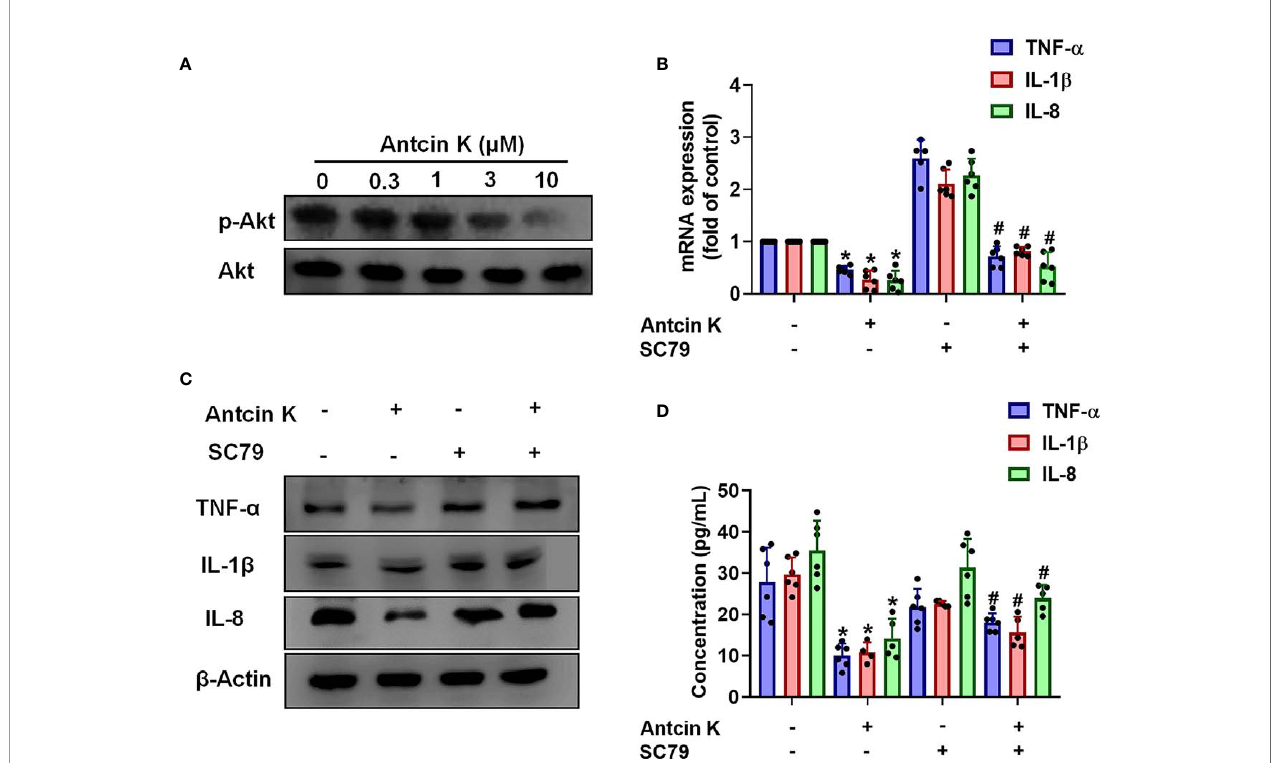
FIGURE 5 | The AKT pathway is involved in Antcin K-induced inhibition of TNF- a , IL-1 b and IL-8 production in synovial fi broblasts. (A) Cells were treated with Antcin K (0.3, 1, 3, or 10 m M) for 24 h and AKT phosphorylation was examined by Western blot. Cells were pretreated with an AKT activator (SC-79) for 30 min, then treated with Antcin K (10 m M) for 24 h. (B – D) TNF- a , IL-1 b and IL-8 mRNA expression and protein secretion were examined by qPCR, Western blot and ELISA. Results are expressed as the mean ± SD. * P < 0.05 compared with controls; # P < 0.05 compared with the Antcin K-treated